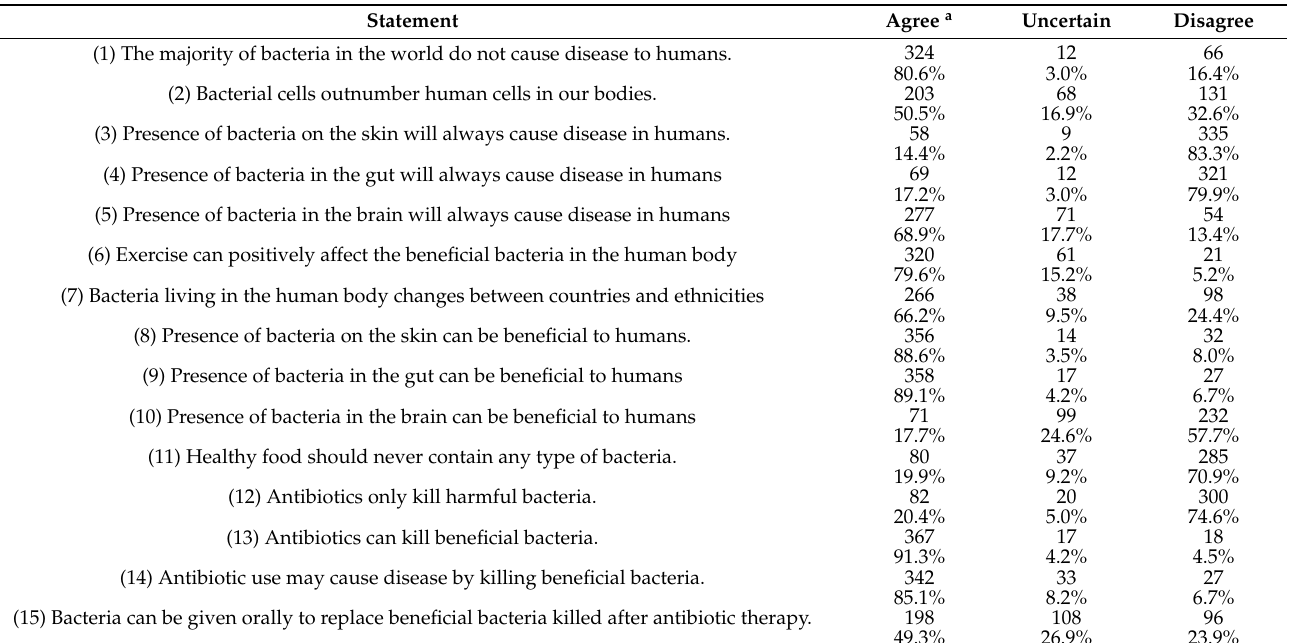
Table 2. Knowledge of microbiota among